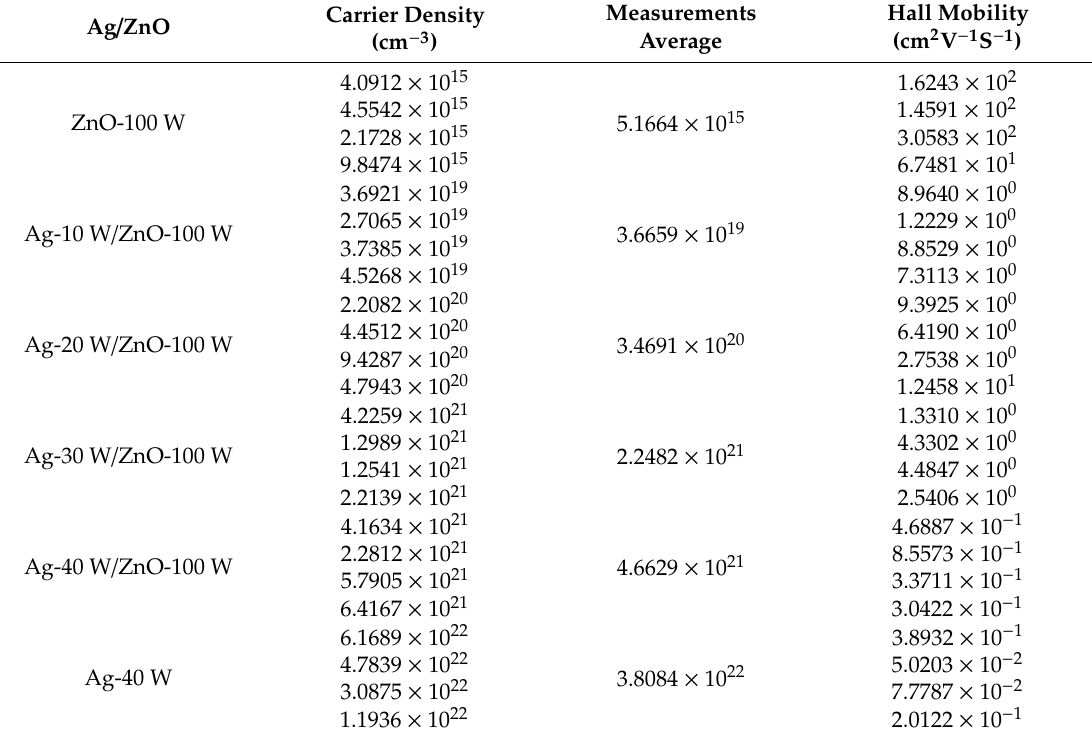
Table 2. Carrier density and Hall mobility detected by the Hall e ff ect system a .